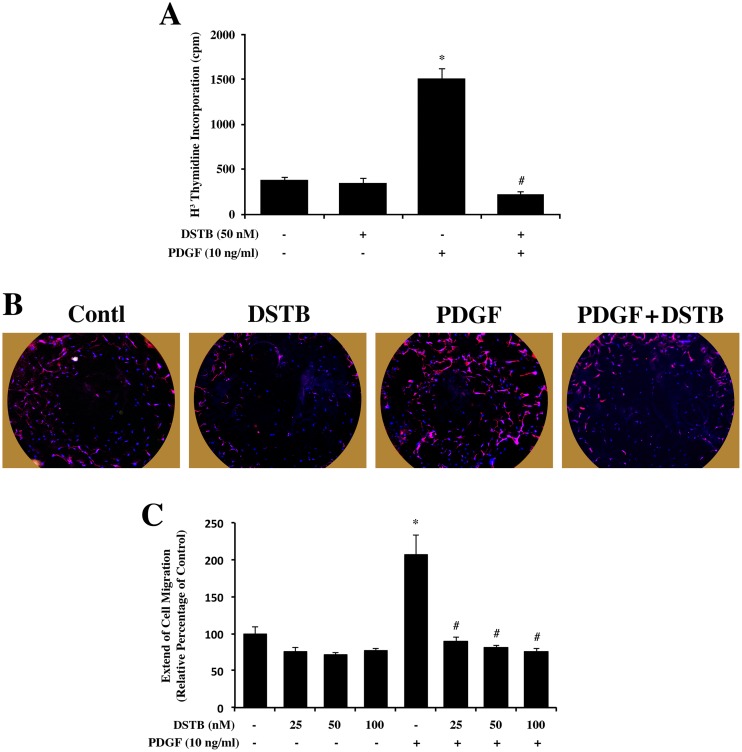
Dasatinib treatment suppresses CFb proliferation and migration.(A) CFb cultured on 24 well plates were serum starved for 12 h and then ± 50 nM dasatinib was added 15 min prior to the stimulation with ± PDGF (10 ng/ml). After 18 h treatment, cells were incubated with 2 μCi/ml 3H-thymidine for 4 h and processed to measure radioactivity as detailed in the Material and Methods. 3H-thymidine data obtained from four independent experiments is shown as mean ± SEM. (B) For the cell migration assay, CFb were plated in 96 well format Oris TM plates (Platypus Technology) and allowed to grow overnight. 50 nM dasatinib or vehicle was added to cells and then stoppers were removed. Cells were stimulated to migrate by adding ± PDGF (10 ng/mL). After 24 h, cells were fixed with 4% paraformaldehyde and stained for actin (phalloidin-Alexa Fluor 568; red) and nuclei with DAPI (blue). The entire well was imaged by fluorescent microscopy at 10X. (C) Quantification from the migration assay is depicted in the graph where dasatinib treatment was performed at various doses. *p<0.05 vs. untreated control; #p<0.05 vs. PDGF.